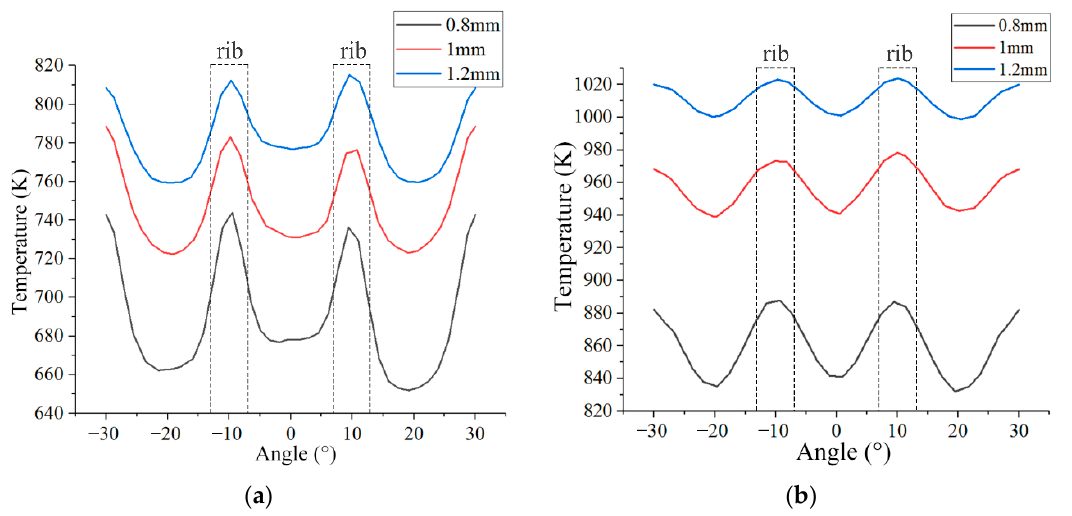
Figure 27. Circumferential variation in temperature on the inner wall under axial positions Z = 20 mm and Z = 175 mm. ( a ) Circumferential variation in temperature under Z = 20 mm; ( b ) circumferential variation in temperature under Z = 175 mm.